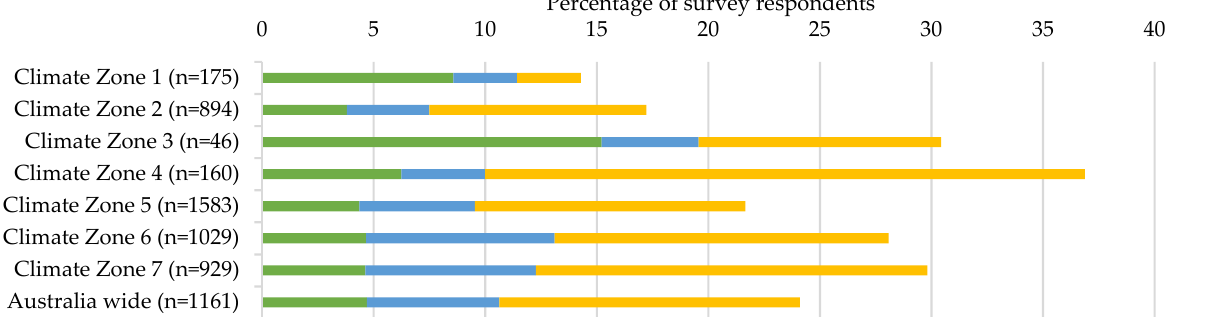
Figure 2. Percentage of survey respondents who reported using firewood in each climate zone across Australia. In terms of climate zone, the use of firewood for indoor space heating was signifi- cantly lower in climate zones with warmer winters (e.g., climate zones 1 and 2, which are characterised by warm winters) and higher in climate zones with cooler winter (e.g., climate zone 4, which is characterised by cool winter, and climate zone 6 and 7, which are characterised as mild and cool temperate,